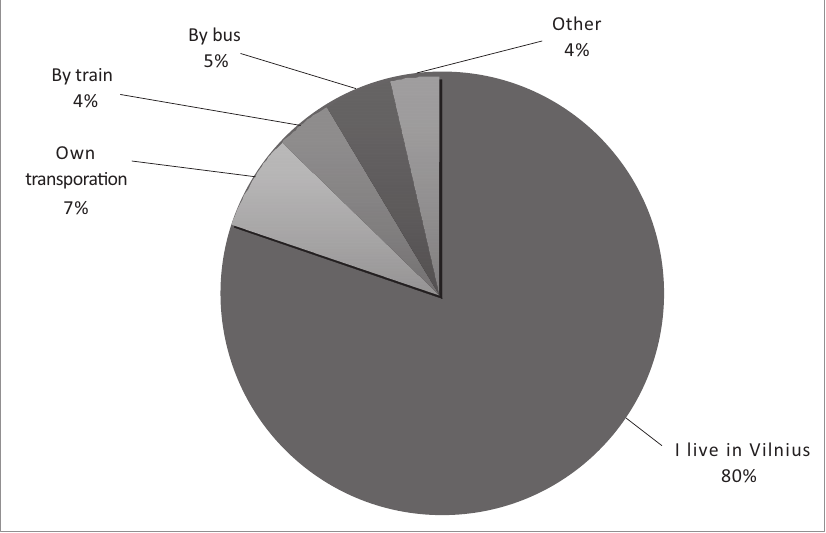
Fig. 11. Transportation type visitors have arrived to the festival